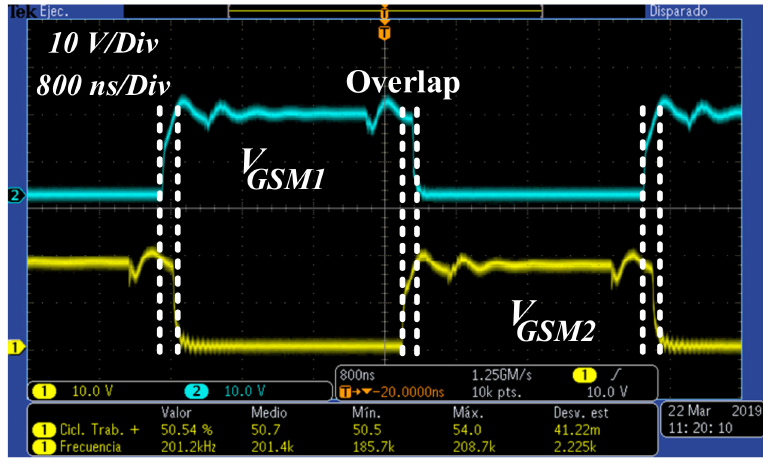
Figure 10. Overlapping signals performed for the first